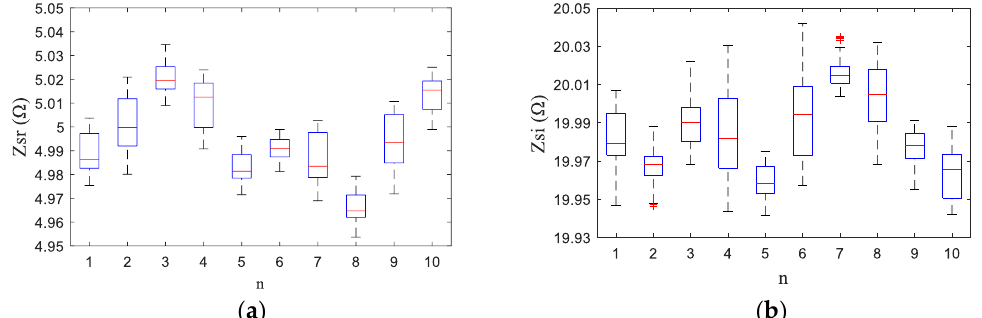
Figure 10. Results of method 2 in simulation II. ( a ) Result of real part; ( b ) Result of imaginary part.